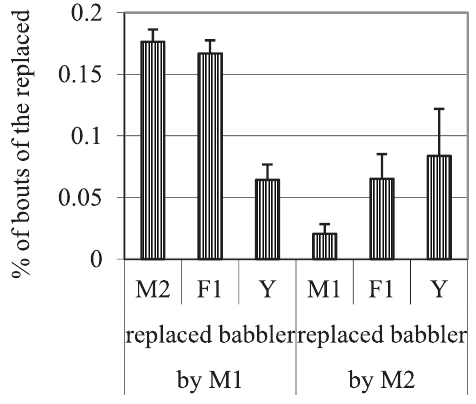
Figure 7. Replacements of adult or young sentinel by M as percentage of the number of guarding bouts of the replaced babbler (groups with young